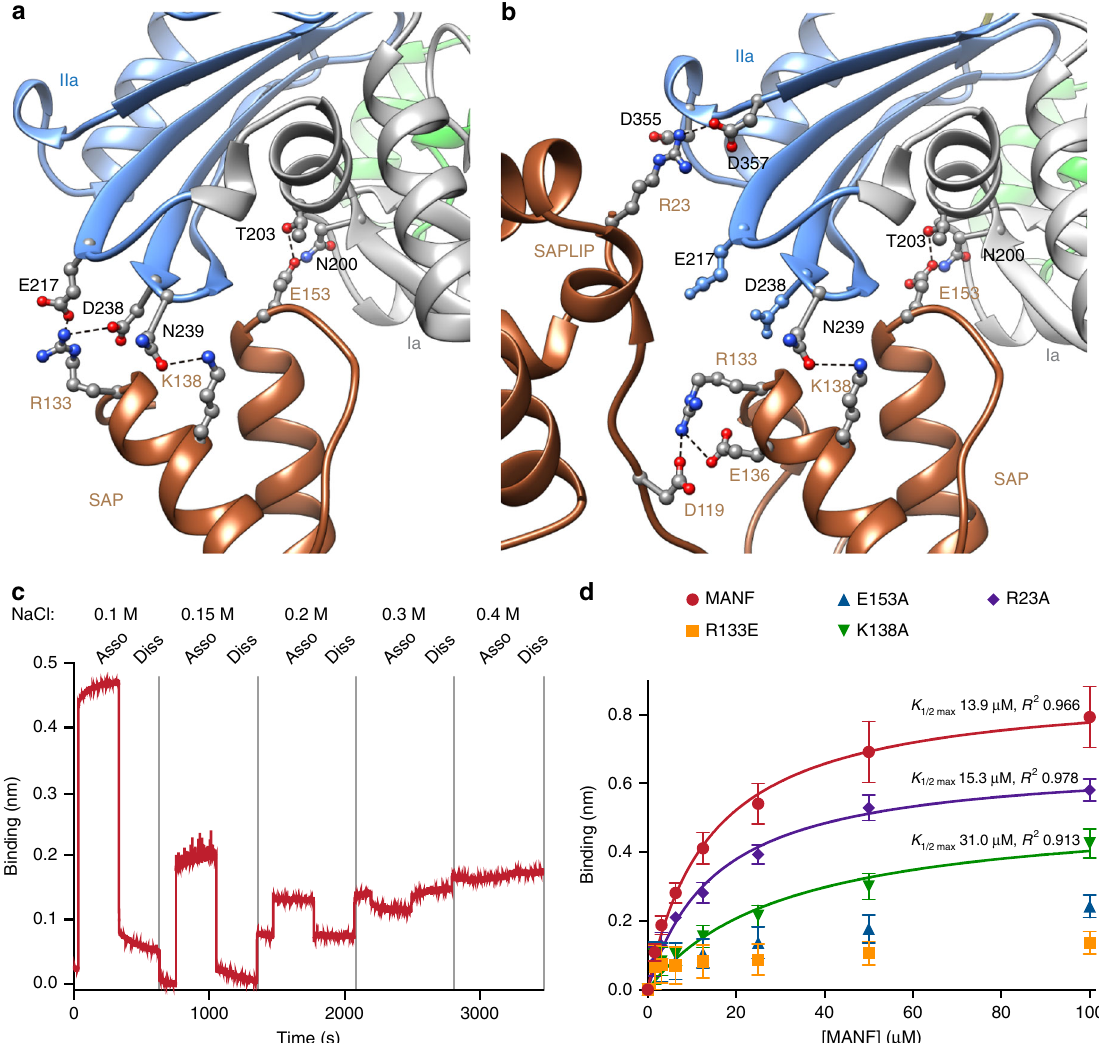
Fig. 4 Electrostatic interactions at the interface of MANF and BiP NBD. a Detailed view of the NBD – SAP interface highlighting R133, K138, and E153 of SAP (gold) that form ionic interactions and hydrogen bonds with indicated residues of BiP NBD subdomains IIa (blue) and Ia (gray). b Detailed view of the NBD – MANF complex structure colored as in ( a ). c Bio-layer interferometry (BLI) trace (association and dissociation phases) of the binding signal arising from the interaction of streptavidin BLI biosensors loaded with biotinylated BiP NBD and exposed to MANF (at 10 µ M) in buffer solutions containing the indicated salt concentrations. Shown is a representative of three experiments. d Plot of the binding signal at equilibrium arising from the interaction of streptavidin BLI biosensors loaded with biotinylated BiP NBD and the indicated concentrations of wild-type MANF or its mutants. Data points represent mean values and SD bars from three independent experiments. The K 1/2 max and R 2 values as well as fi t lines are provided for the wild-type MANF and the R23A and K138A mutants. K 1/2 max and R 2 values are not provided for the R133E and E153A mutants as these gave rise to binding signals that were too weak to fi t to a saturable one-site binding model. Source data are provided as a Source Data fi